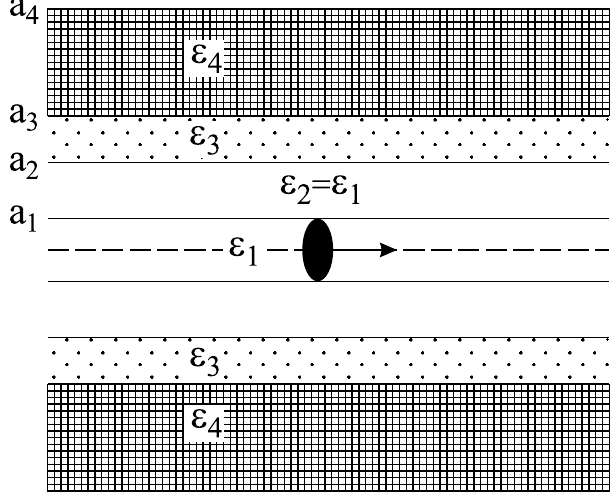
FIG. 1. Geometry of the